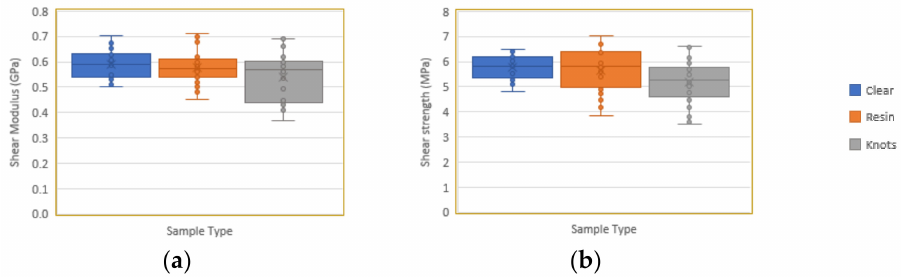
Figure 24. Box plots of ( a ) Shear modulus and ( b ) shear